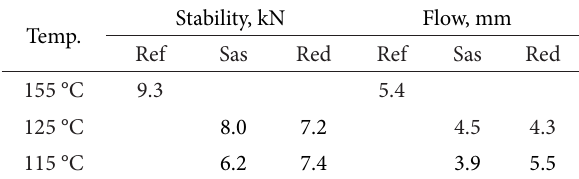
Table 2. Marshall test results